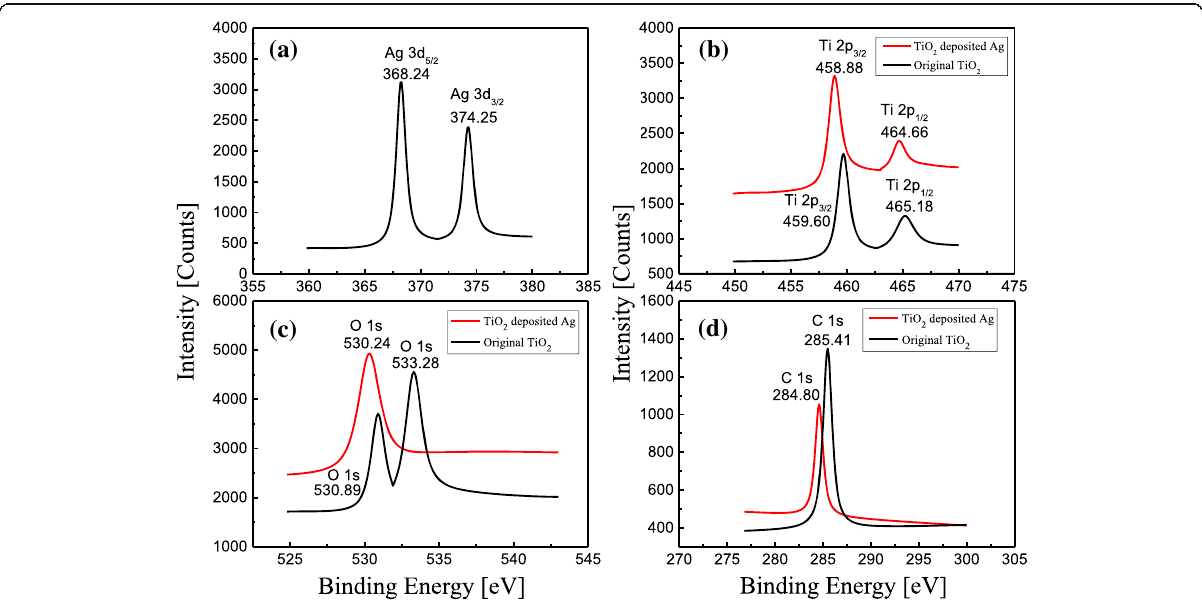
Fig. 4 Photoelectron spectroscopy of the spectra of Ag in ( a ); and the spectroscopies of TiO 2 Nanotubes with/without Ag Deposition in ( b ), ( c ) and ( d ) Measured by XPS, respectively